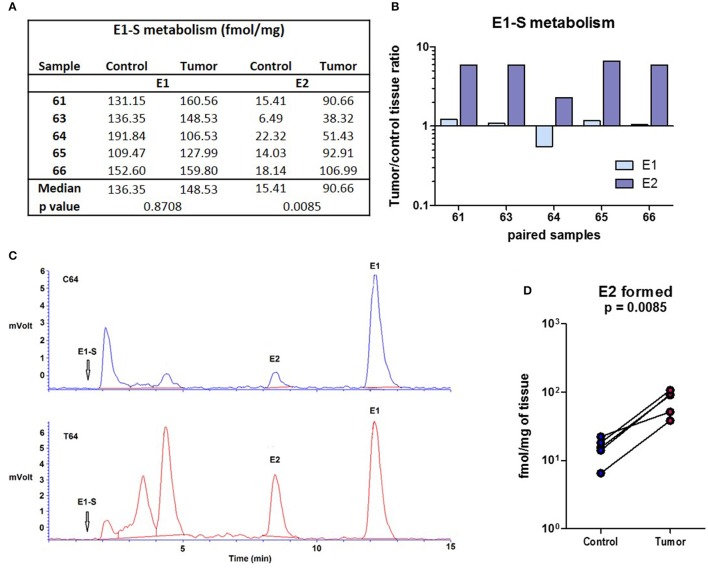
E1-S metabolism in the EC and adjacent control endometrium. (A) Table for the conversion of E1-S to E1 and E2 (fmol/mg powdered tissue) in control and corresponding EC. (B) Histogram with logarithmic scale demonstrates increased tumor/ control tissue ratio for E2 formation in all paired samples. (C) HPLC elution profiles shows the formation of E2 and E1 from 3H labeled E1-S (16 nM) for the representative samples of control (C64) and corresponding cancer (T64) tissues. Rf of E1-S and formation of several unidentified polar metabolites is also shown. (D) Before-and-after graph demonstrates levels of E2 formed in control endometrium (Control) and the corresponding EC (Tumor) for samples 61, 63, 64, 65, and 66.